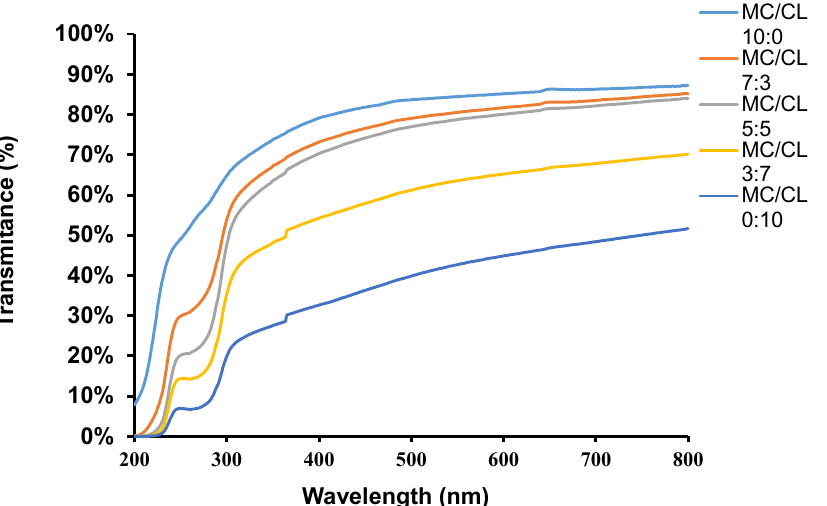
Figure 8. Light transmittance of the MC/CL films with different blend ratios. Table 1. T 500 of the MC/CL films with different blend ratios.